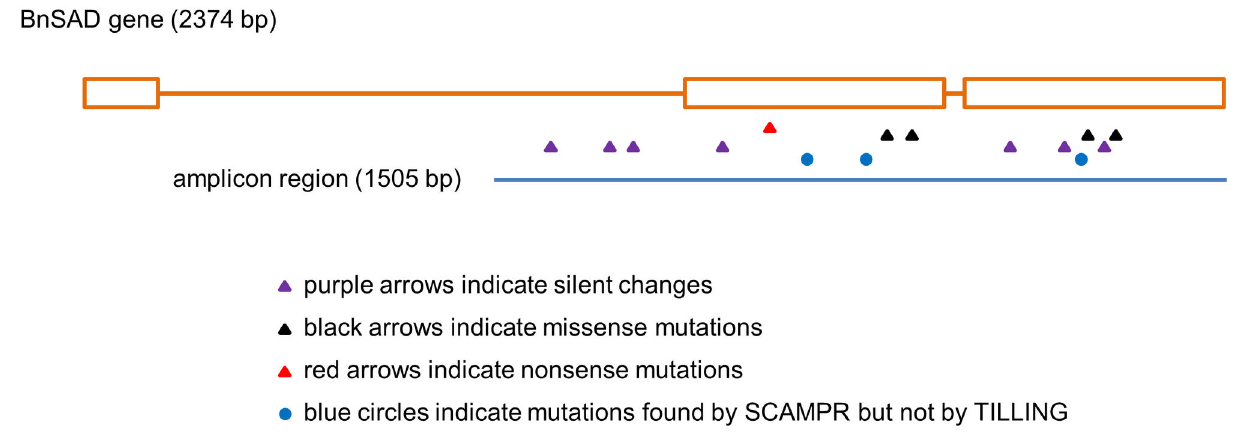
Figure 2. Diagrammatic representation of the distribution of mutations identified by classical TILLING and by SCAMPRing. The BnSAD gene was used as a test to compare the effectiveness of NGS sequencing (SCAMPRing) vs. classical TILLING. Purple arrows indicate silent changes in the gene that are predicted to have no effect on the protein gene product. Black arrows indicate predicted missense mutations that alter the amino acid sequence of the protein product. Red arrows indicate predicted nonsense mutations that result in premature truncation of the protein. Circles indicate mutations that were detected using SCAMPRing but not originally found with classical